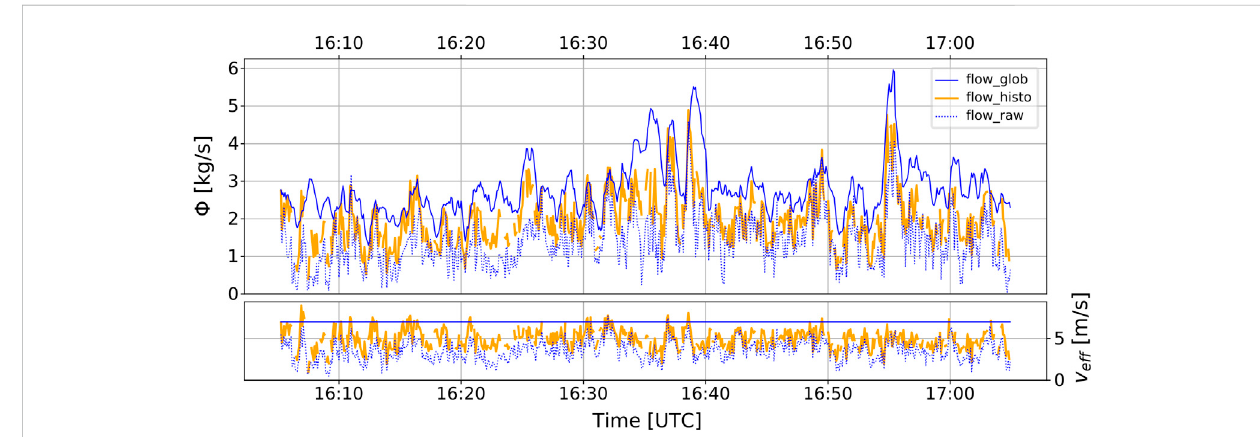
FIGURE 6 Emissionrate( Φ )timeseriesandassociatedeffectivevelocityestimation( V eff )using3differentplumespeedestimationalgorithms.Thesinglecross- correlation velocity is faster than optical fl ow velocities for the majority of the series, but peak optical fl ow velocities match quite well with this cross- correlation speed. We suggest fl ow_histo (bold orange) is likely to provide the most reliable data in general; however, at times this algorithm is unable to compute a reliable speed, therefore some parts of this time series are absent. Data from Lascar volcano on 20th May 2022; times are in